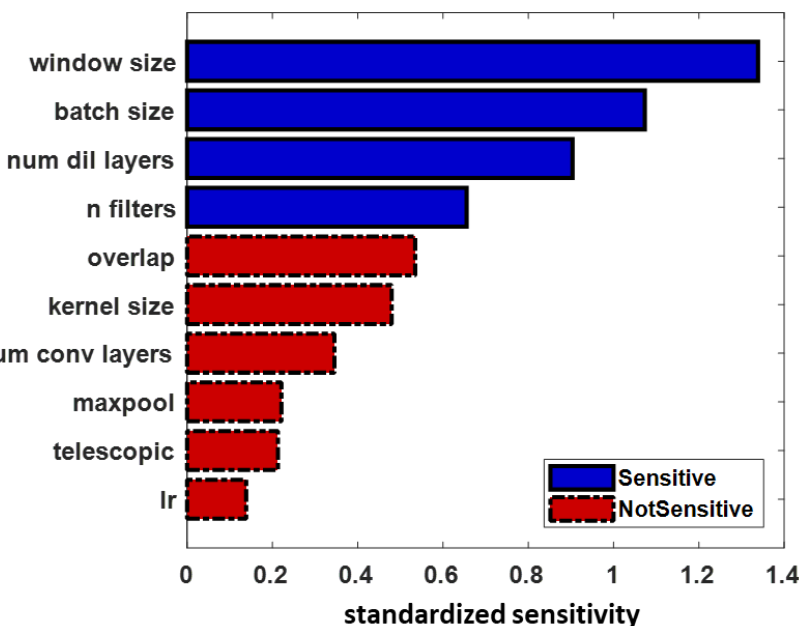
Figure 14. Sensitivity analysis of hyperparameters. Parameters are num conv layers: number of convolutional layers; num dil layers: number of dilated convolutional layers; n filters: number of filters; lr: learning rate, window size: training example size; overlap: training example overlap; maxpool: max pooling; telescopic: telescopic architecture. The parameters are described in 0.